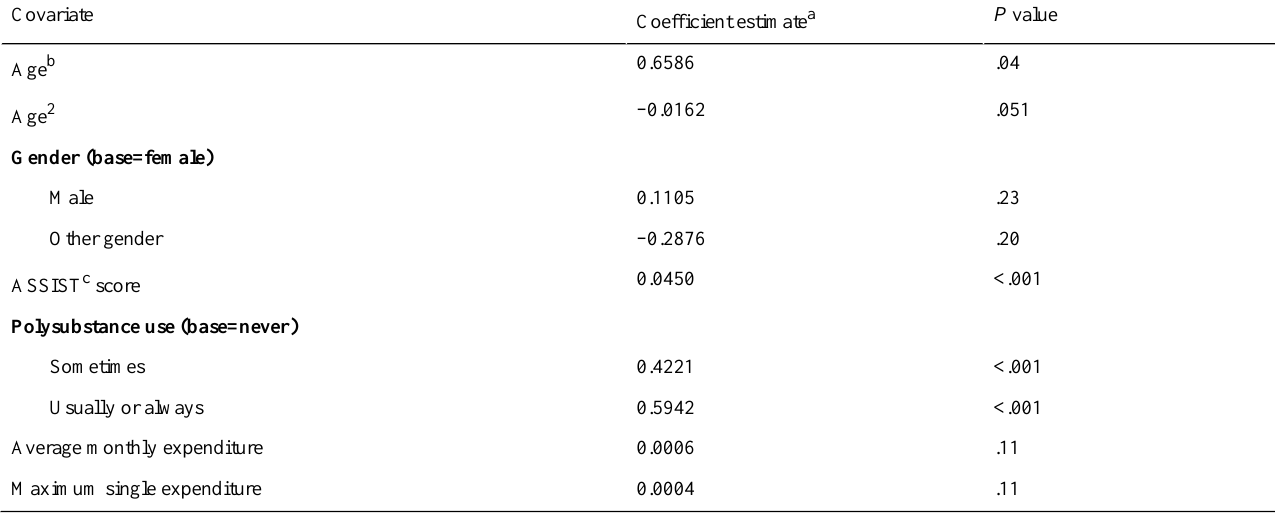
P valueCoefficient estimate a